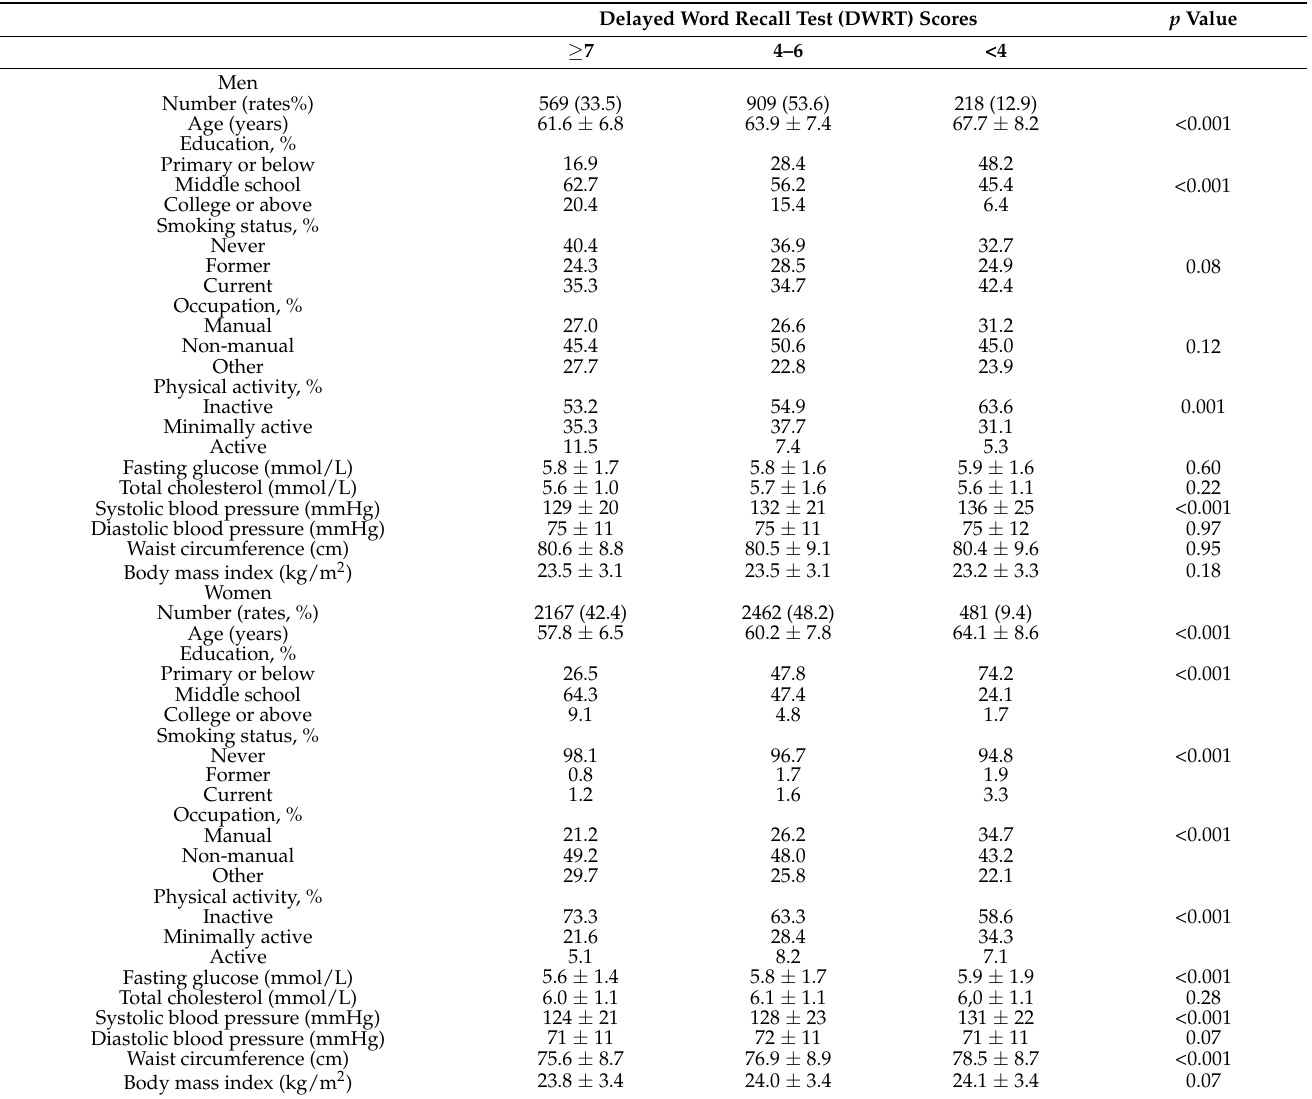
Table 1. Characteristics of the Delayed Word Recall Test (DWRT) groups in 1696 men and 5110 women from the Guangzhou Biobank Cohort Study by sex. Delayed Word Recall Test (DWRT) Scores p Value ≥